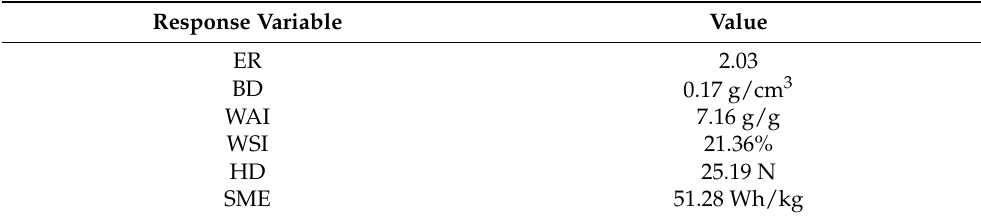
Table 3. Physical characteristics of extrudates at the optimal combination of independent